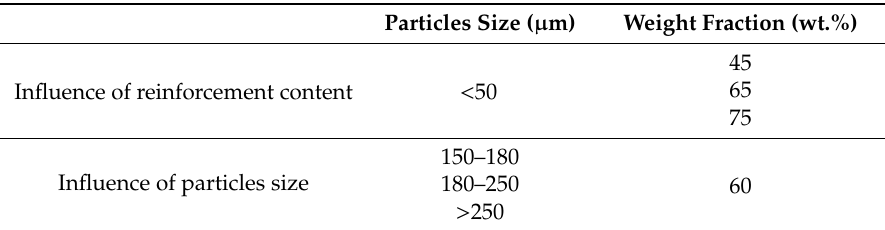
Table 1. Parameters of manufactured composites.